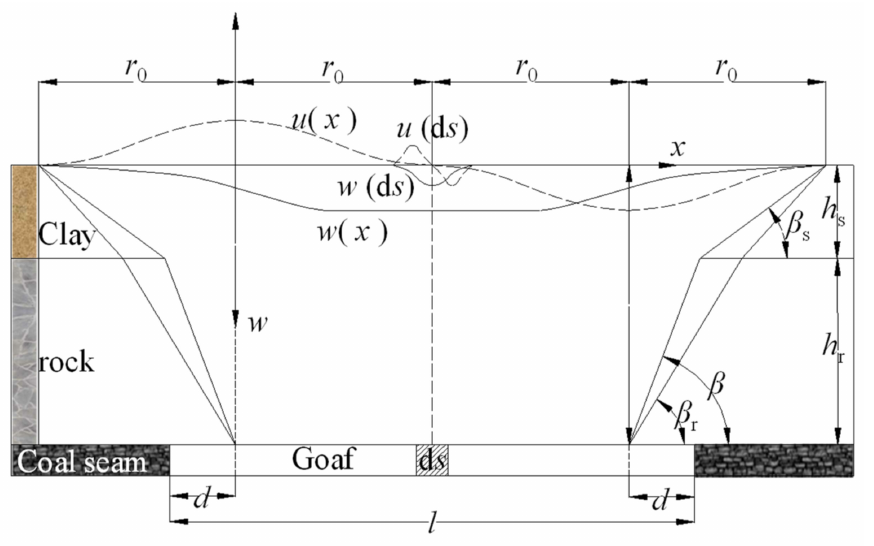
Figure 1. Coal seam unit mining integral